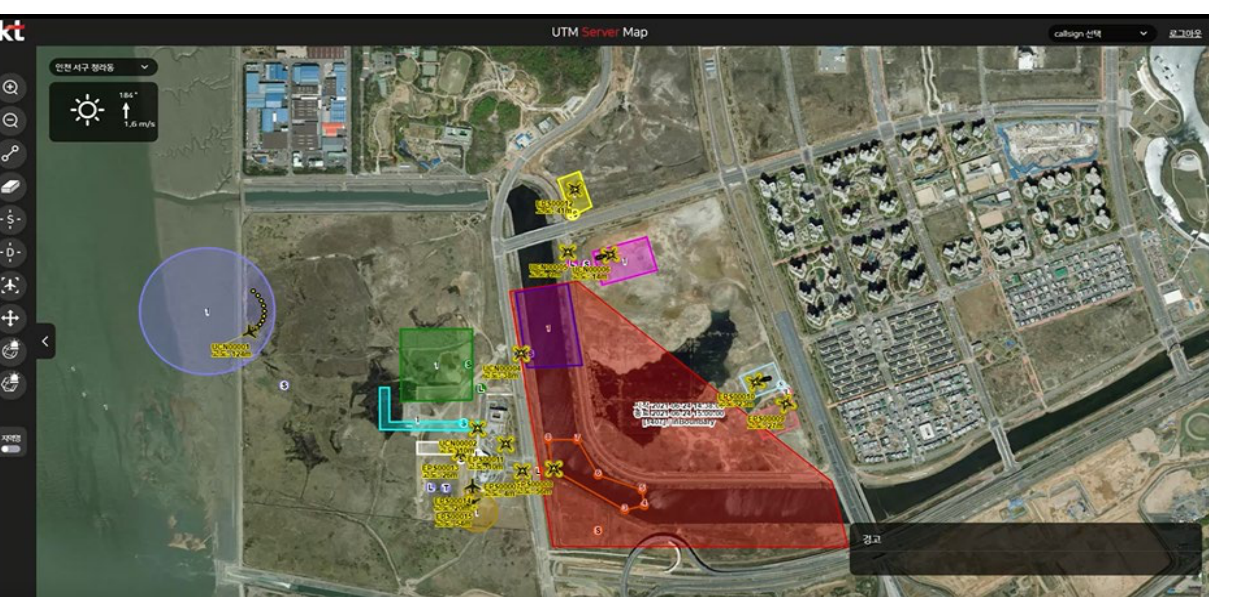
Figure 6. 13 drones simultaneously flying in their mission regions.